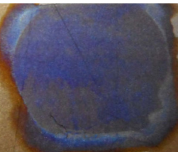
Figure 20. Images of titanium anode after electrolytic polymerization designating 9 in Table